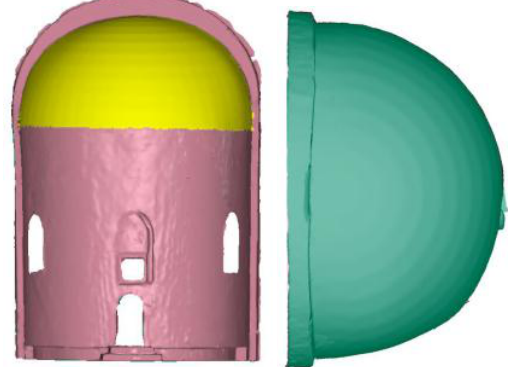
Figure 12. Front view of the existing apse (pink) and historical shapes (yellow) inside the virtual 3D model of the original apse before the earthquake (left), top view (right)